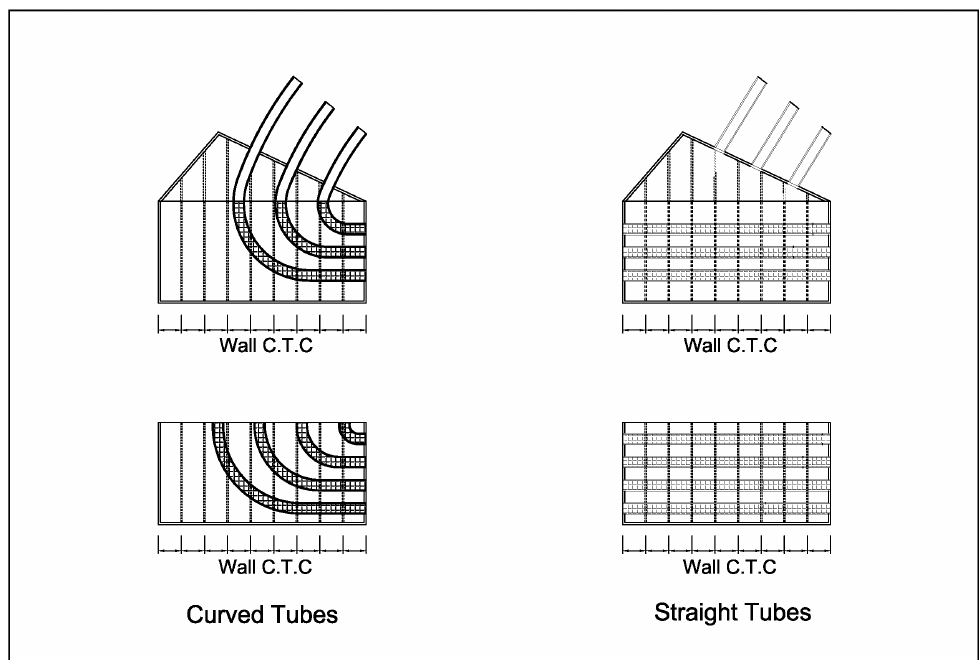
Figure 2. Sectional view of breakwater structure showing two types of internal tube designs (C.T.C. stands for centre-to-centre).